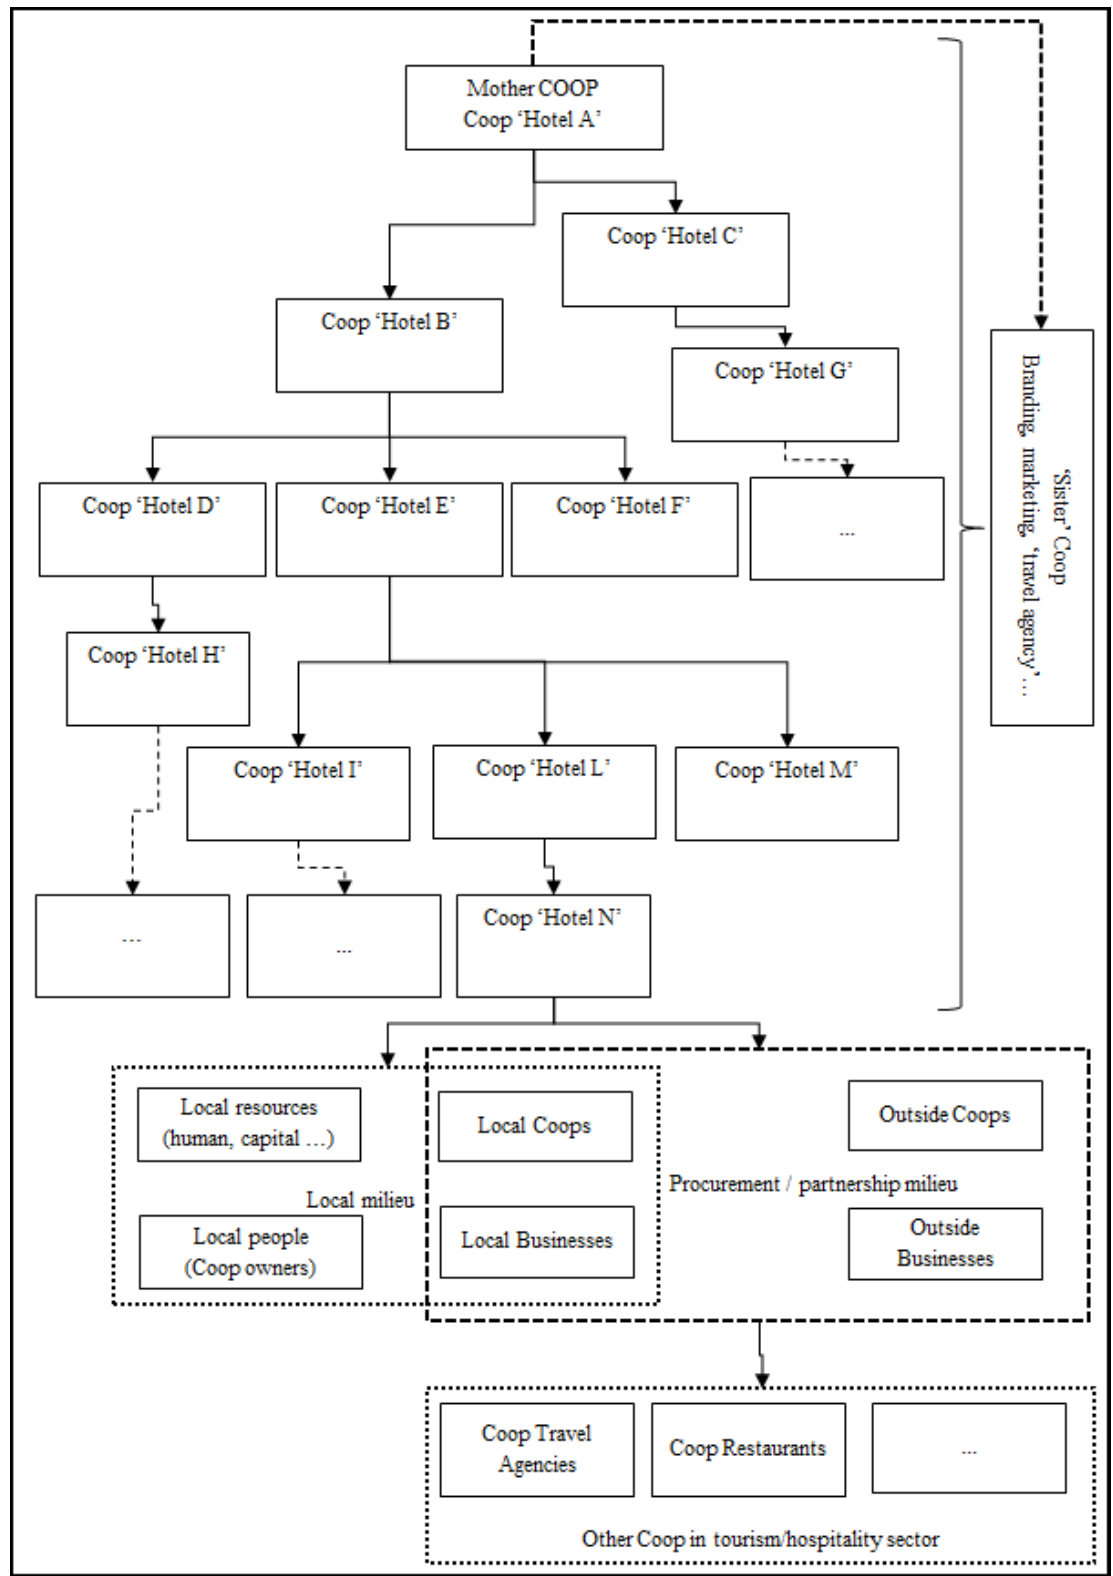
Figure 3. Coop hotel model. Authors’ elaboration.